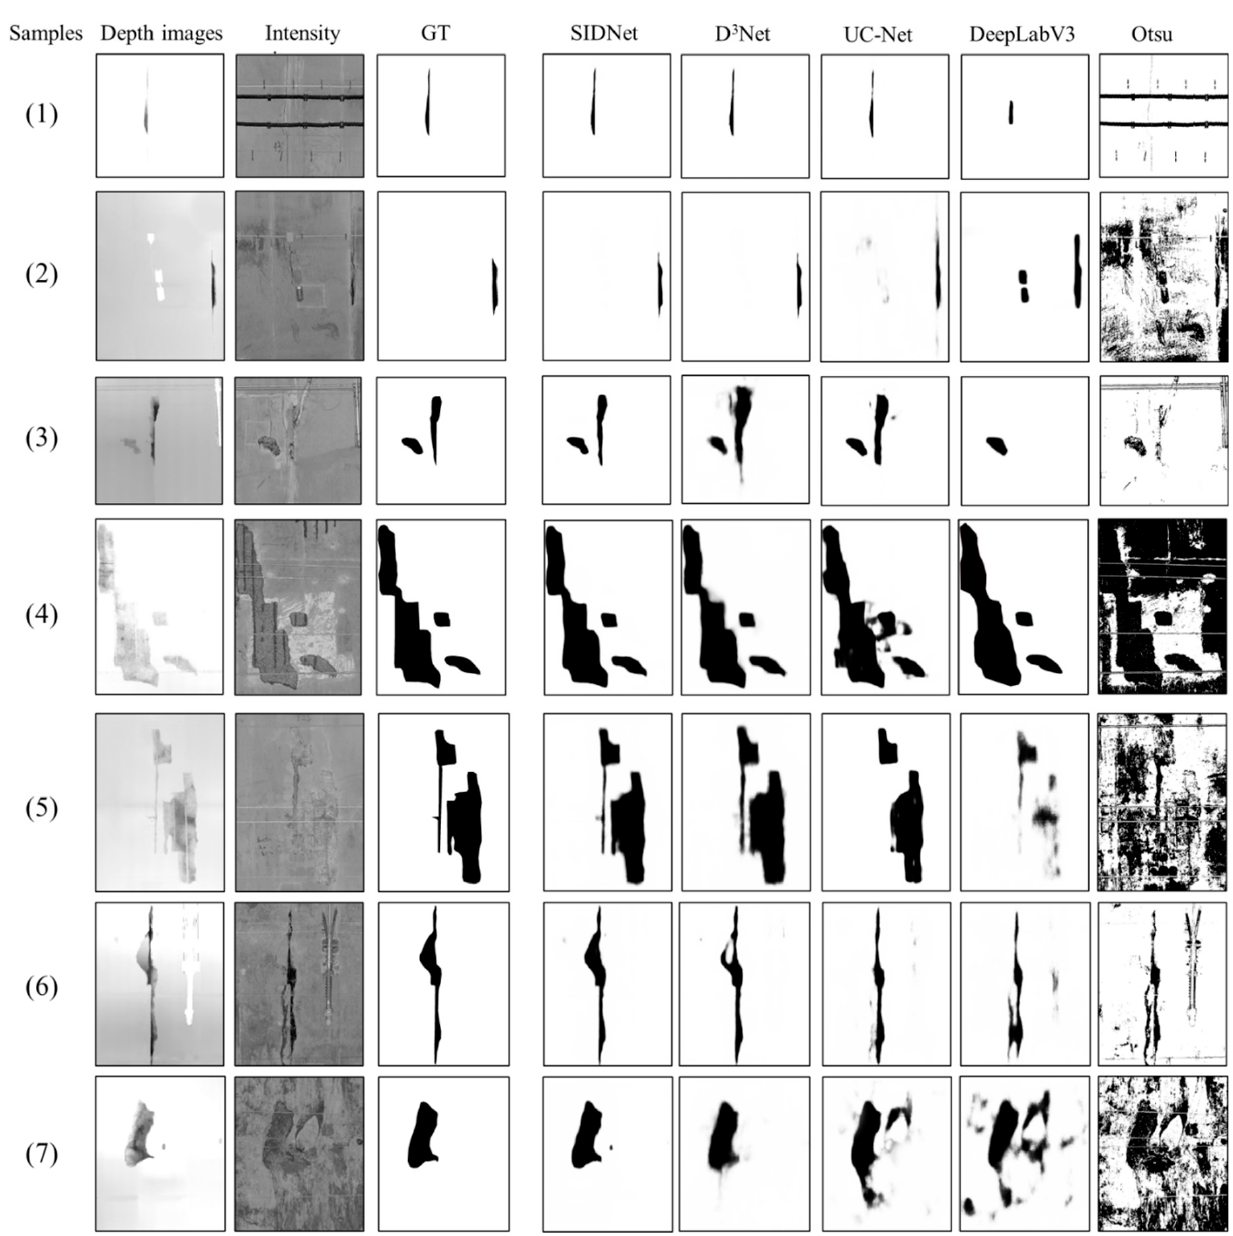
Figure 13. Comparison of the inspection results using several different algorithms, including deep learning-based methods and the traditional threshold segmentation method.